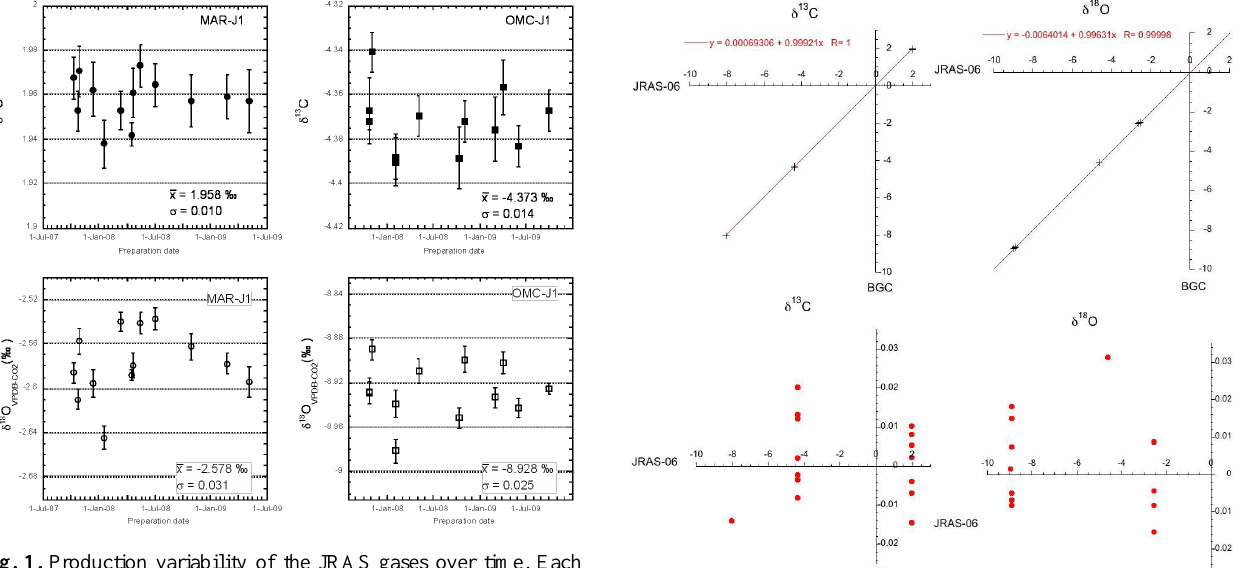
Figure 1. Production variability of the JRAS gases over time. Each data point represents an average of nine measurements of the prepared CO 2 -air mix, three per flask within a batch. Thus the overall standard deviation (1-σ) reflects the combined variability between the prepared CO 2 as well as the uncertainty related to the extraction and mass spectrometric measurements performed in the MPI BGC laboratory. Table 2. δ 13 C results. Linear regression resulting from comparing local scales to JRAS-06.